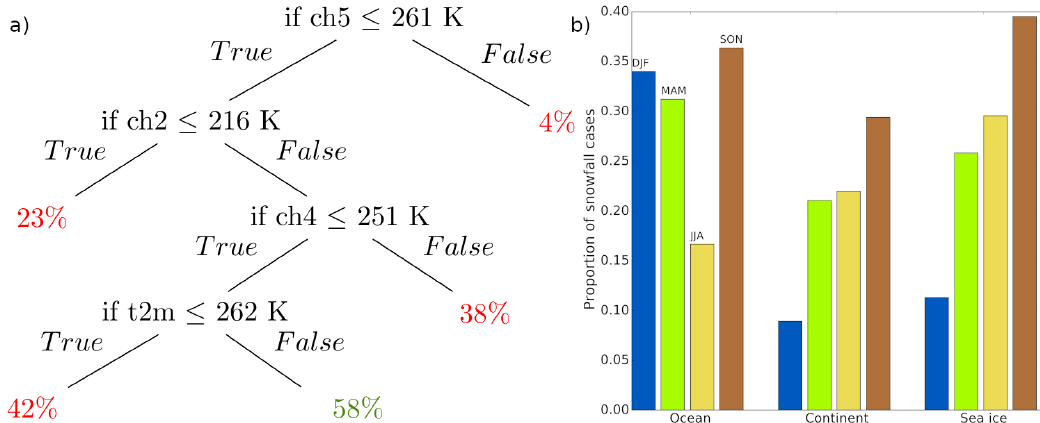
Figure 10. ( a ) Decision tree classifier with the environmental variables and BT as inputs. The percentage of the number of snowfall cases with respect to the total number of profiles is shown for each leaf node. Proportions greater than 50% are shown in green; otherwise, they are shown in red. ( b ) Proportion of snowfall events in the “snowfall group” with respect to the total number of snowfall events as a function of the season and the surface